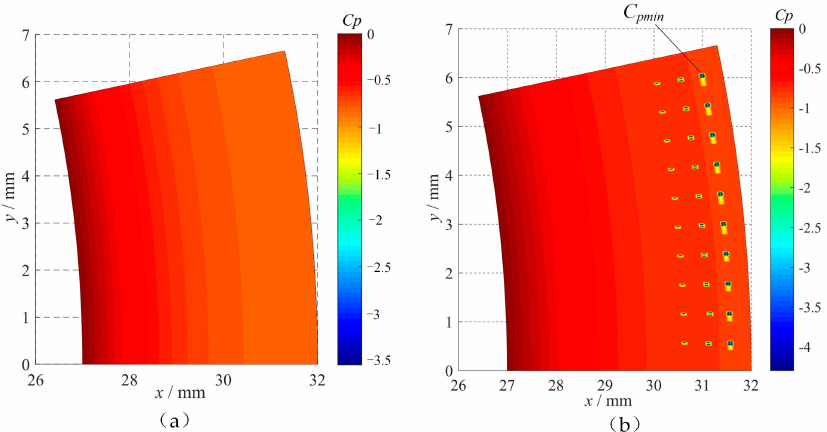
Figure 11. Pressure coefficient of nontextured oil film and textured oil film (( a ) is oil film with textures; ( b ) is oil film without textures).